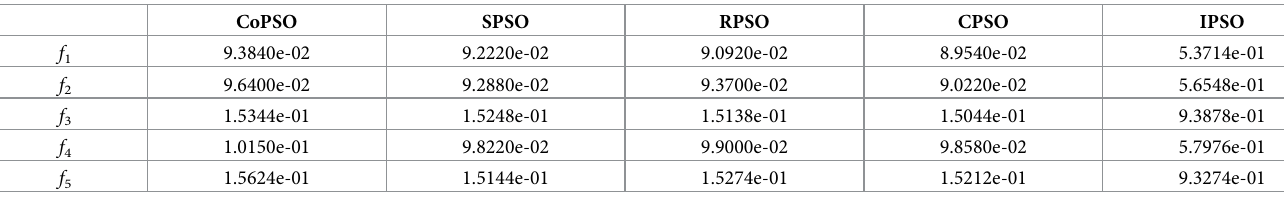
Table 3. Average runtime for all algorithms on benchmark functions (in